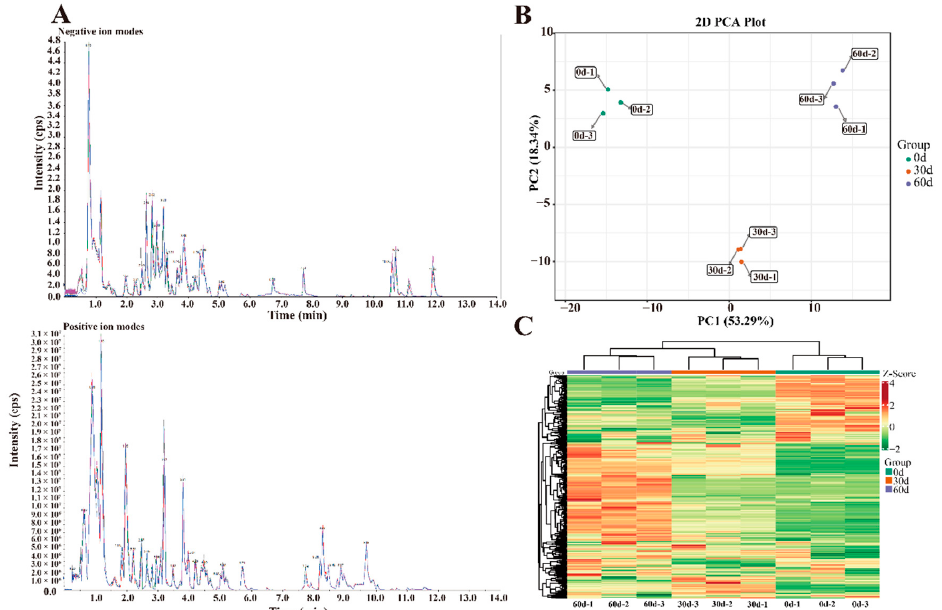
Figure 2. Differences in ‘Fengtang’ plum fruit samples at different storage periods: ( A ) TIC overlap map detected by mass spectrometry (MS), ( B ) PCA score map, and ( C ) Cluster thermogram of primary metabolites.